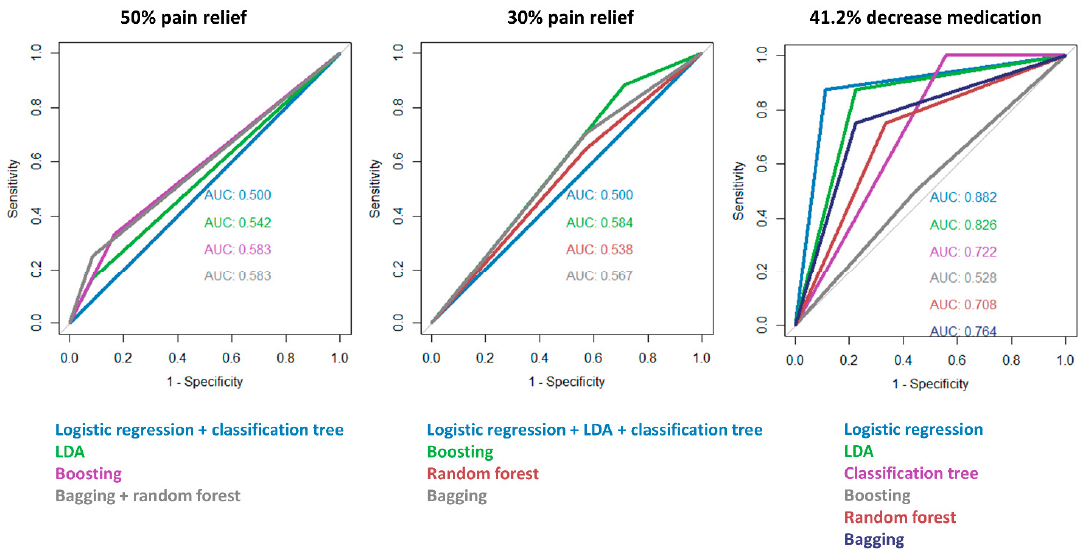
Figure 4. The receiver operating characteristics (ROC) curves of the different machine learning classification models for responders defined as 50% pain relief (left), 30% pain relief (middle) and 41.2% pain medication use reduction (right).